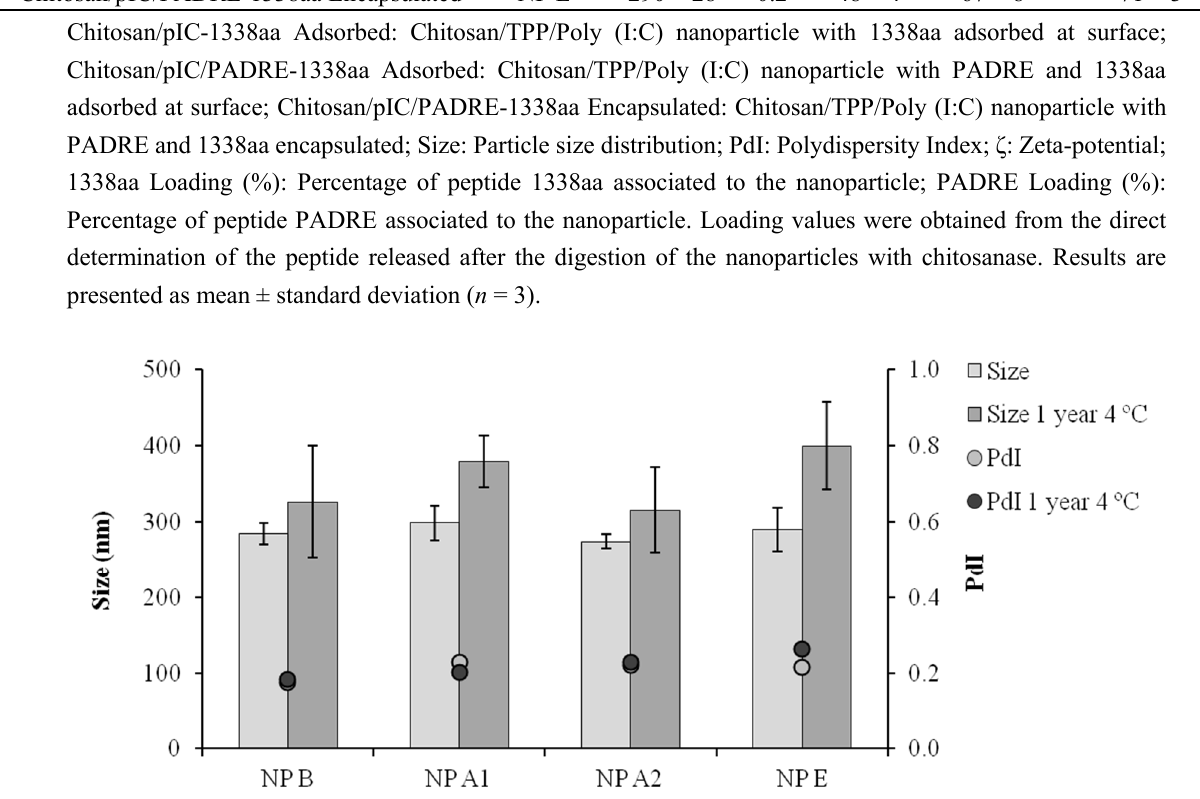
Table 3. Physicochemical characteristics and loading efficiency of Chitosan/TPP/Poly (I:C) nanoparticles (Chitosan/pIC) loaded with 1338a and PADRE peptides. Formulation Code Size (nm) PdI ζ (mV) 1338aa (%) PADRE (%) Chitosan/pIC without peptide (Blank) NP B 284 ± 15 0.2 +41 ± 1 N/A N/A Chitosan/pIC-1338aa Adsorbed NP A1 299 ± 23 0.2 +49 ± 5 39 ± 1 N/A Chitosan/pIC/PADRE-1338aa Adsorbed NP A2 274 ± 9 0.2 +47 ± 5 50 ± 5 75 ± 13 Chitosan/pIC/PADRE-1338aa Encapsulated NP E 290 ± 28 0.2 +48 ± 4 67 ± 8 71 ± 3